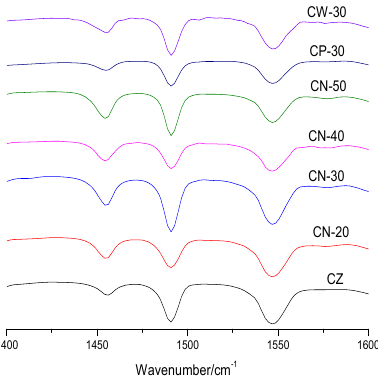
Figure 7. Py-FTIR spectra of the catalysts. Figure 7. Py ‐ FTIR spectra of the catalysts. By using ICP characterization the aluminum content of CZ is measured as 1.18%, and the silicon content is 45.64%; therefore, the Si/Al ratio of CZ is 37.30. In Table 1 the NH 3 - TPD and Py-FTIR quantitative results of the catalysts are shown. The relationship between the total acid amount and binder content is not obvious after adding the binder, while the molding method has an obvious effect on acid distribution, indicating that different methods cause different interactions between the binder and HZSM-5 raw powder. The quantitative acid results of NH 3 -TPD show that the total acid amount first increases and then decreases gradually with an increase in the binder content. The acid amount of CN-30 is the highest, at 0.73 mmol NH 3 /g. The total acid amount of CN-20 and CN-40 is about 0.65 mmol NH 3 /g; that of CN-50 and CP-30 is similar, 0.56–0.57 mmol NH 3 /g; and CW-30 is the least, at only 0.45 mmol NH 3 /g. The results above show that the acid density of CN-30 is the highest and that of CW-30 is the lowest. The total acid amount of CN-20, CN- 30 and CN-40 is higher than that of CZ; however, the acid strength of CN series catalysts decreases combined with NH 3 -TPD spectra. As mentioned above, this may be due to the chemical interaction between the binder and HZSM-5 zeolite powder by adding dilute nitric acid to the wet extrusion process, resulting in the formation of new acid centers [23]. No matter what molding method is used, the acid strength distribution is greatly modified by adding a binder of